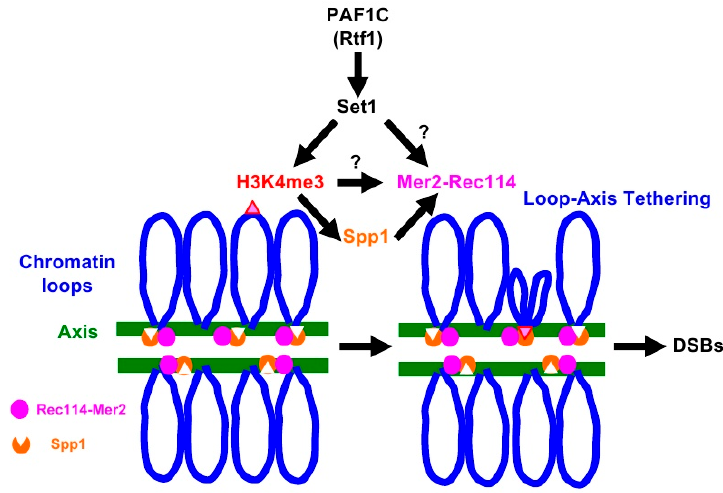
Figure 1. Loop-tethering to the chromosome axis promotes double-strand break (DSB) formation. See details in the text.